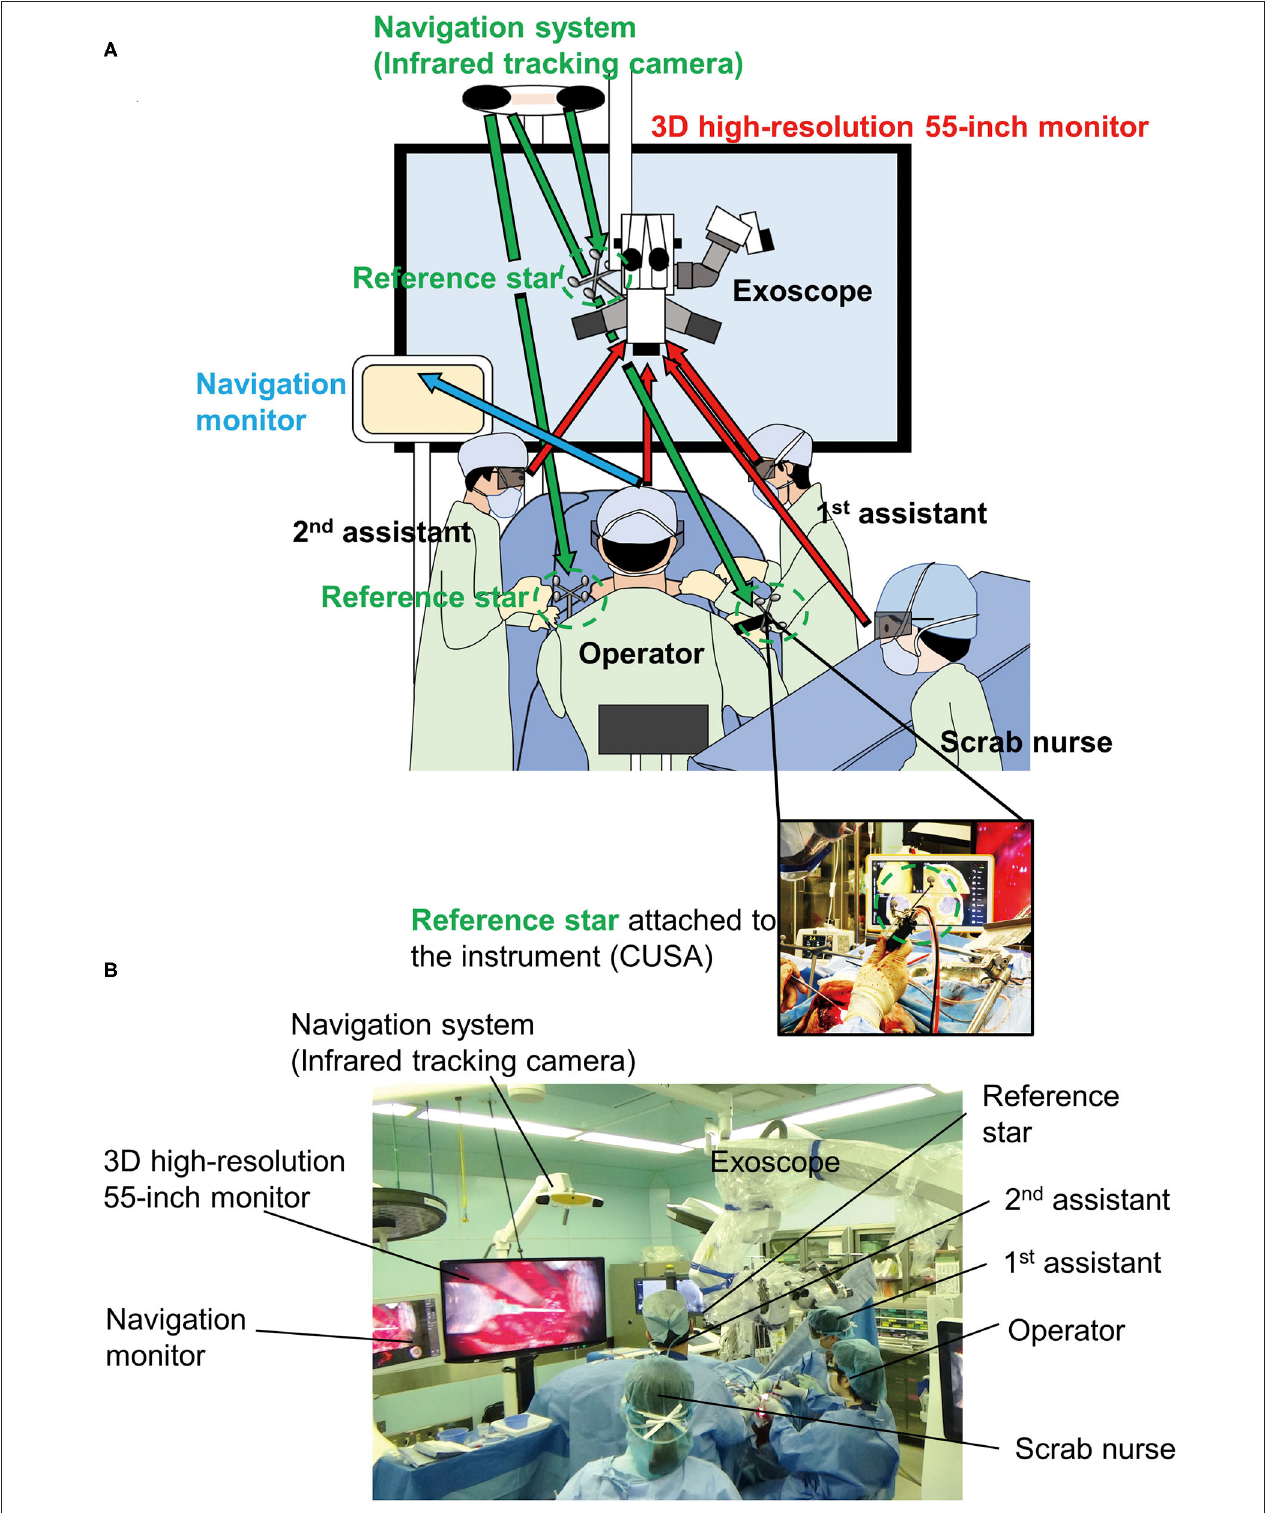
FIGURE 1 | Equipment, operating room setup, and patient positioning. (A) Illustration of a three-surgeon–six-hand operation using a 4K-3D exoscope is shown. (B) Actual setup in the operation room. Arrows means viewpoint of each staff.